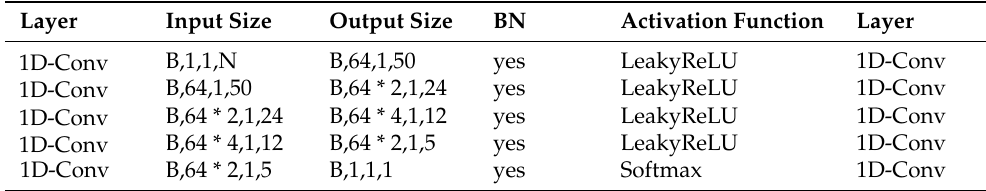
Table 2. MS-PGAN’s discriminator network structure